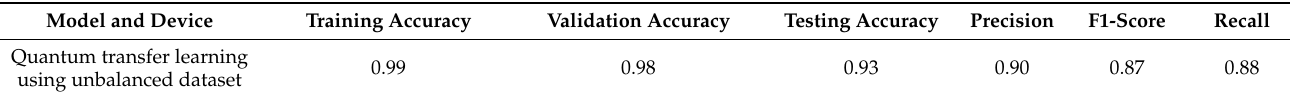
Figure 11. Accuracy plot and loss plot for the PennyLane default simulator with ResNet34. Table 5. Results of quantum transfer learning model using an unbalanced dataset.